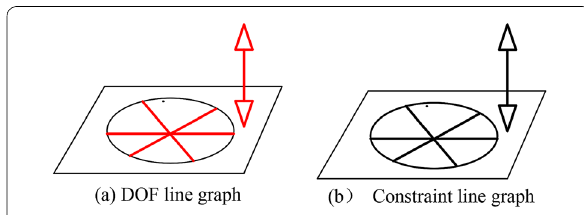
Figure 2 F&C line graph of mobile